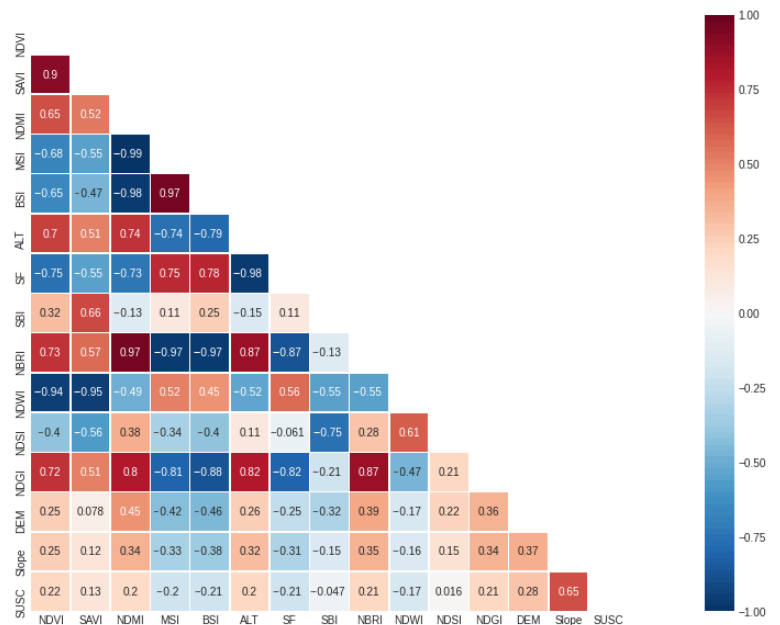
Figure 6. Correlations between bands (B2–B8, B8A, B11, B12), 12 spectral indices (see the list in Table 1), DEM, slope and the susceptibility label (SUSC).